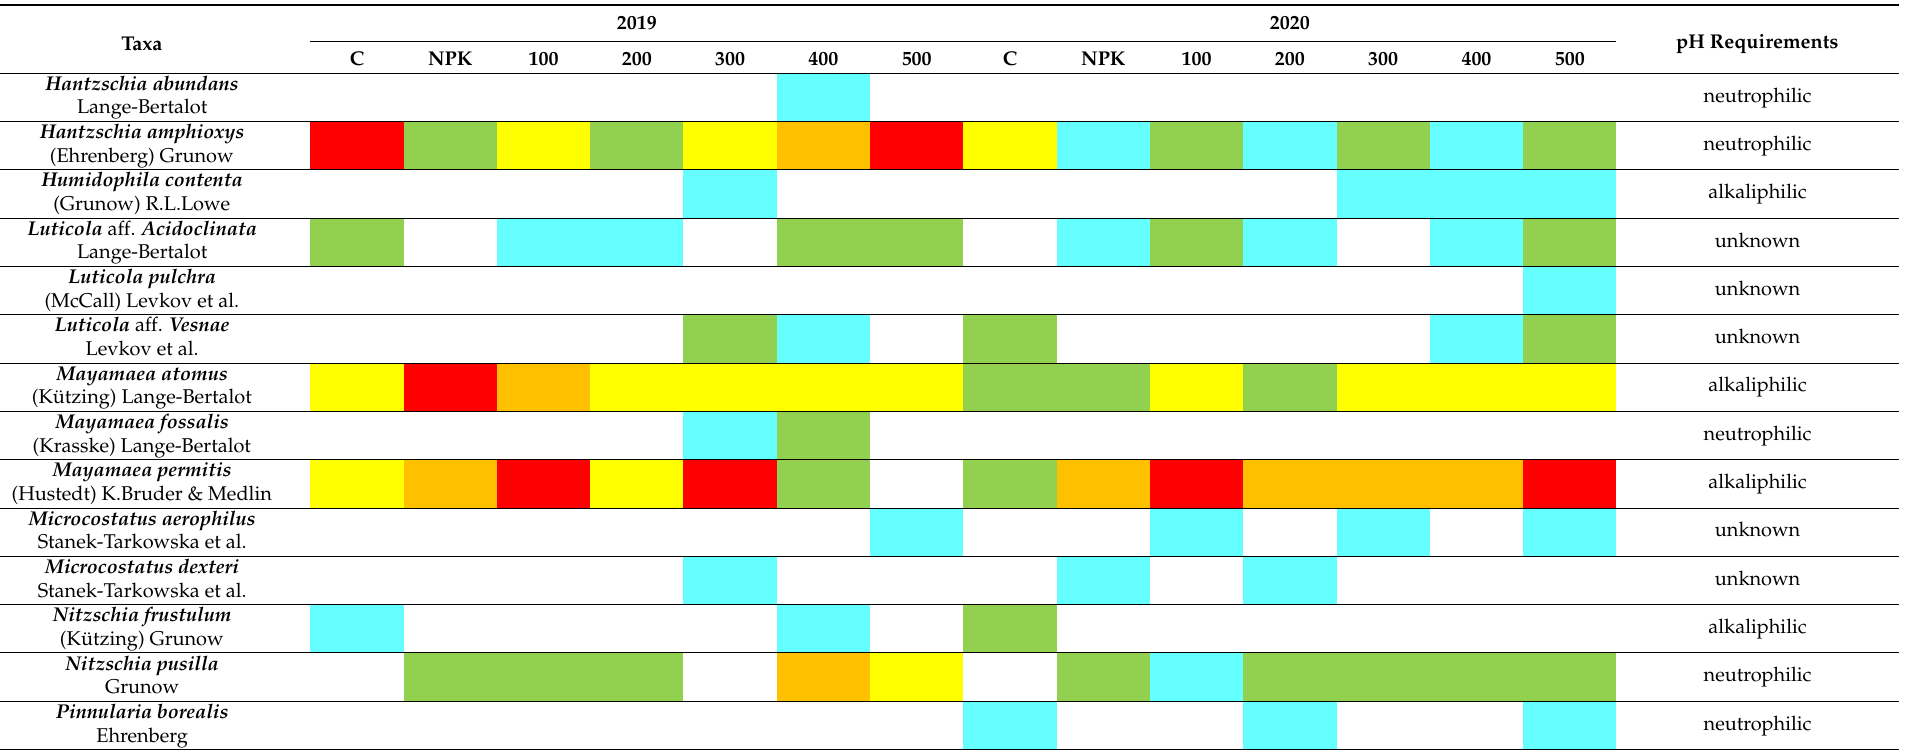
Table 4. List of identified taxa together with the percentage share in the assemblage and pH requirements (according to Van Dam et al., 1994). C—control (without fertilization), NPK K 2 O in mineral fertilizers, 100–100 kg K 2 O ha − 1 in ash (0.5 t ha − 1 of ash in bulk weight), 200–200 kg K 2 O ha − 1 in ash (1.0 t ha − 1 of ash in bulk weight), 300 − 300 kg K 2 O ha − 1 in ash (1.5 t ha −